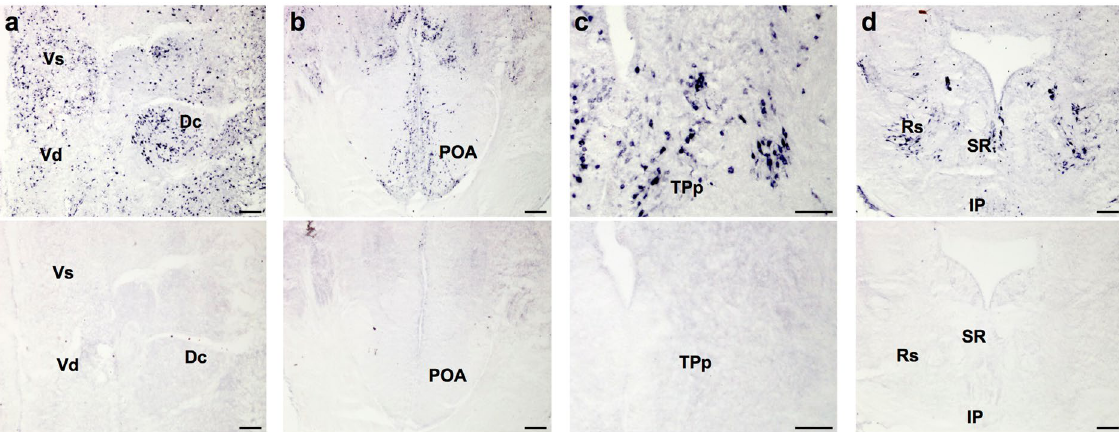
Figure 2. Representative coronal sections in different brain regions showing pS6 antibody specificity. Positive pS6 staining produces clear distinctly stained cells throughout many brain regions (top row), but staining is completely eliminated when the antibody is pre-absorbed with a pS6 blocking peptide on adjacent sections (bottom row). See text for abbreviations. Scale bars represent 100 µ m in ( a , b and d ), and 50 µ m in ( c